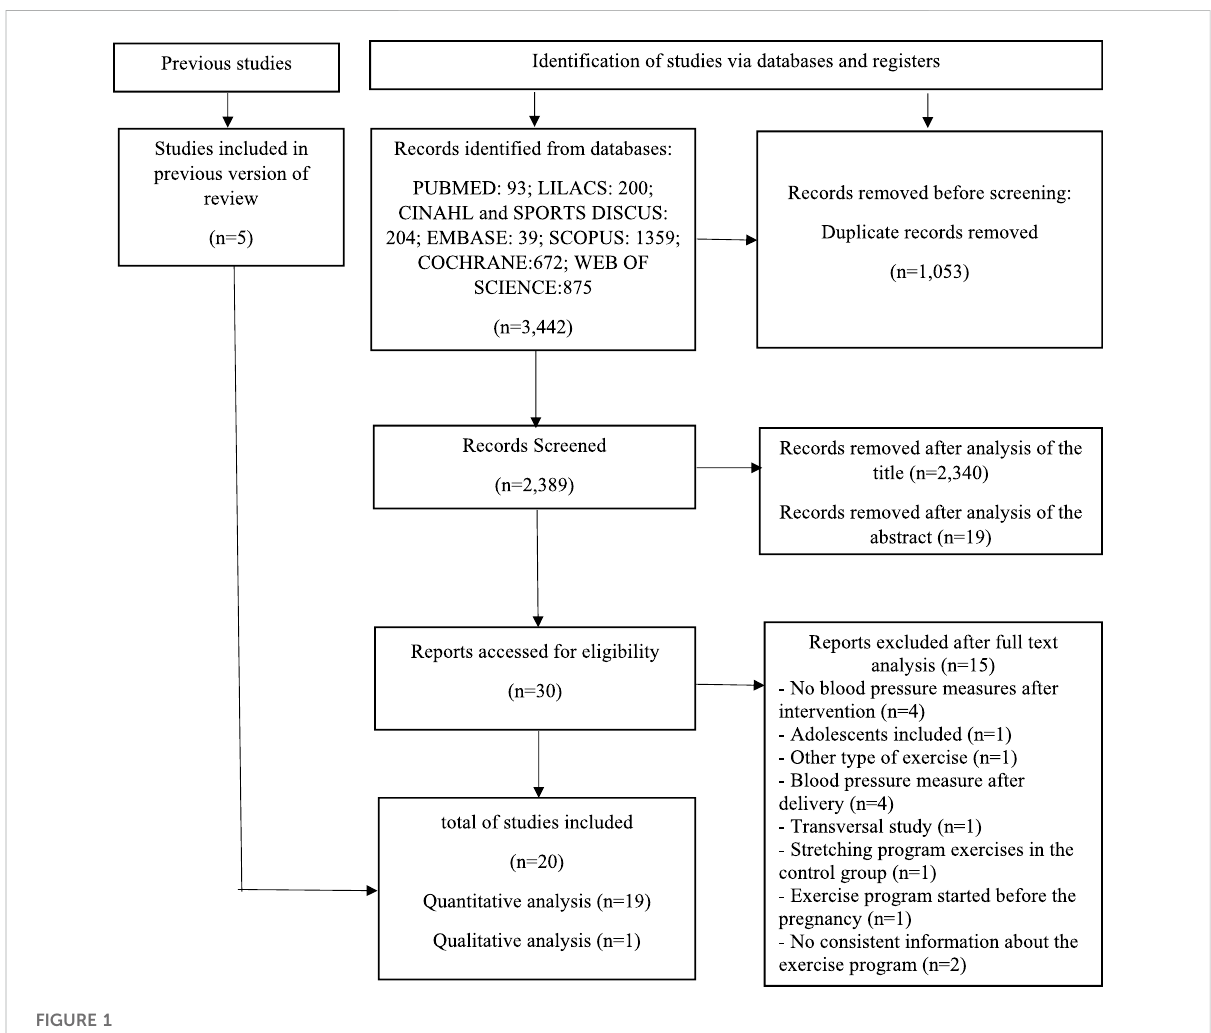
FIGURE 1 Flow diagram for study